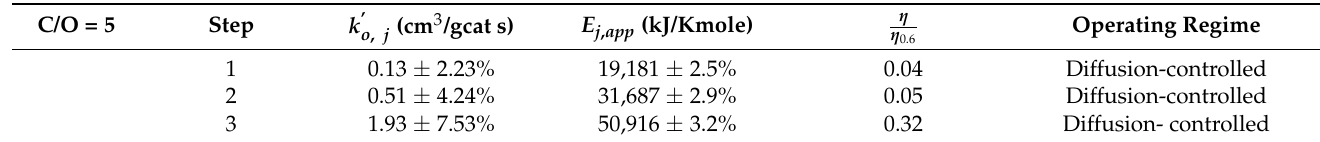
Table 3. Frequency Factors, Activation Energies and Estimated Operating Regimes at Various C/O Conditions  14  .